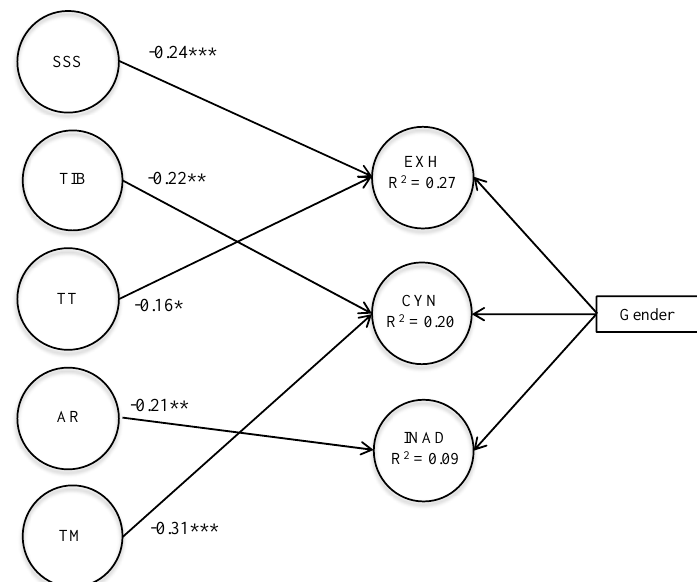
Figure 2. Estimated final model with predictors (only statistically significant regression coe ffi cients are given). SSS = Support for Struggling Students, TIB = Teachers’ Instructional Behavior, TT = Teaching Time, AR = Application of rules, TM = Teachers’ motivation; EXH = Exhaustion, CYN = Cynicism, INAD = Inadequacy; * p < 0.05, ** p < 0.01, *** p <